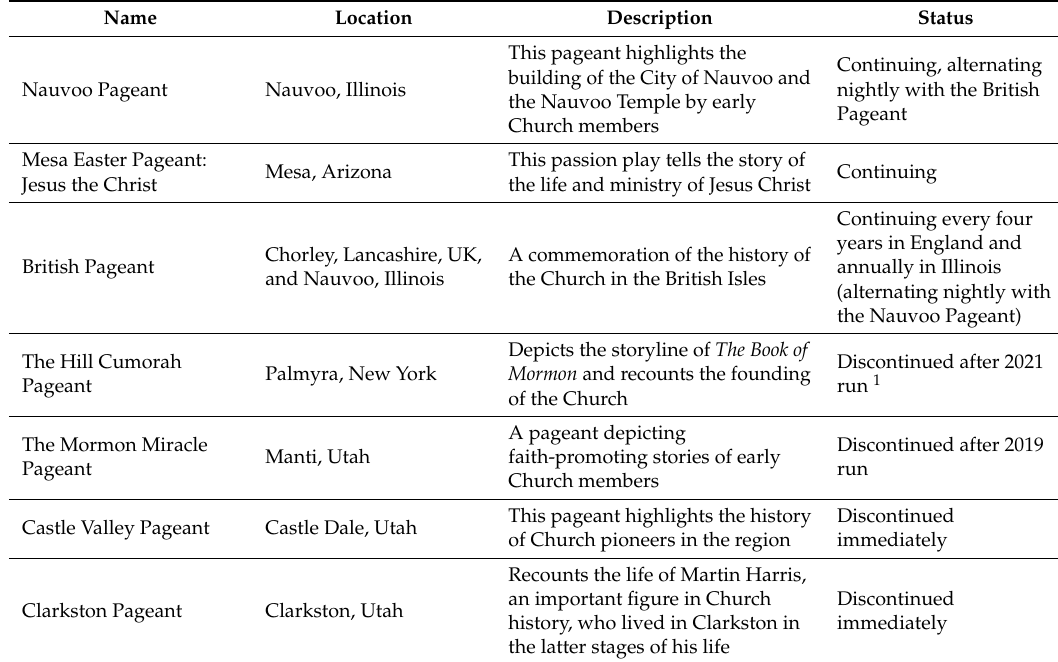
Table 1. A list of Church pageants prior to the discontinuance announcement (Olsen and Timothy 2018; Weaver and Roe